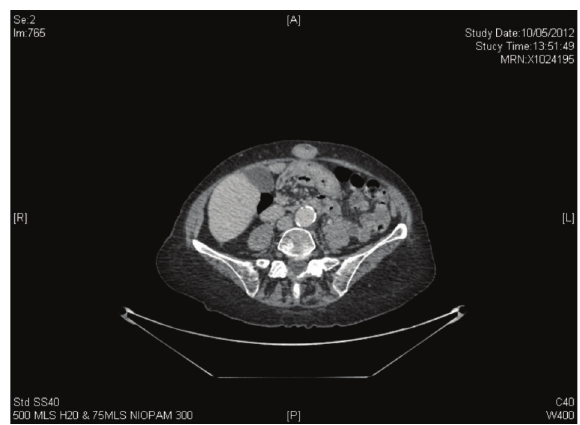
Figure 1: Sister Mary Joseph’s